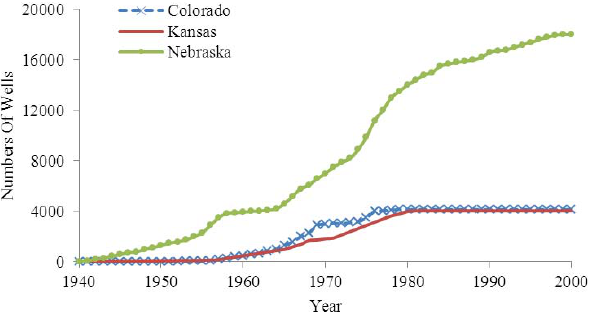
Fig. 1. Accumulative number of active groundwater pump- ing wells of Colorado, Kansas and Nebraska in RRB (adopted from Republican River Compact Administration http://www.republicanrivercompact.org/v12p). Starting in the 1960s, groundwater-fed irrigation has become the largest aquifer water use in this region.